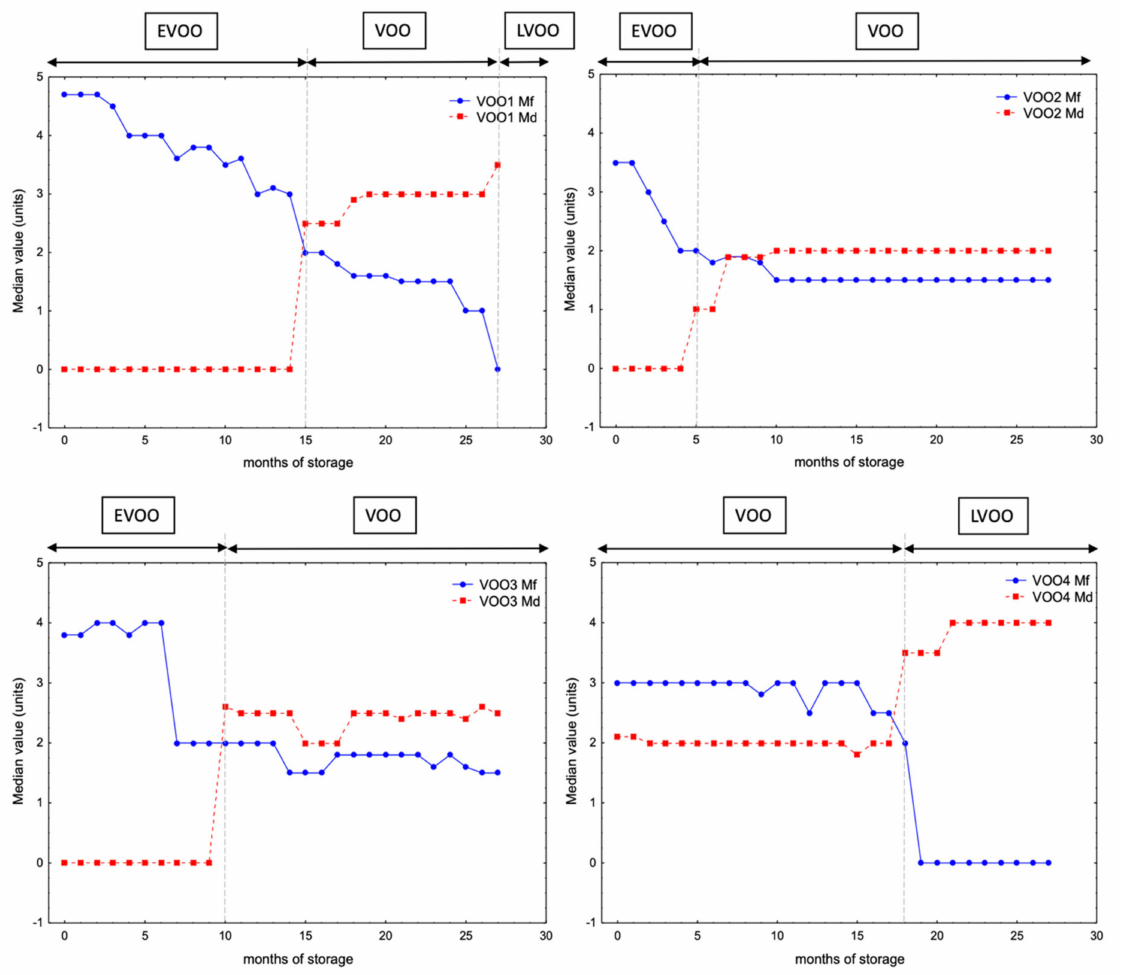
Figure 2. Changes of the oil category, the median of the fruity attribute (Mf) and the median of defect (Md) for the four virgin olive oils (VOO1–VOO4) during the